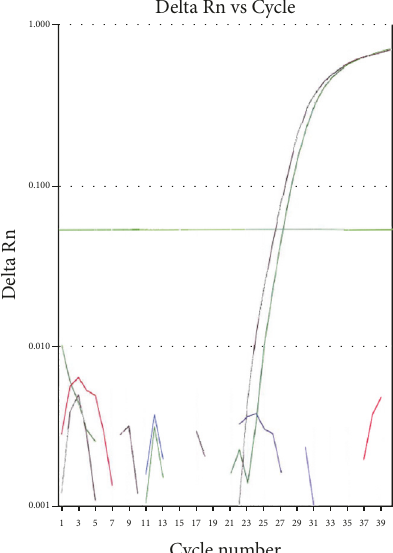
Figure 4: Real-time RT-PCR showing the MLL/MLLT10 fusion transcripts from patient #1. Delta Rn = normalized fluorescence reporter signal minus baseline; cycle number = cycle of PCR; purple is the positive control; green is the patient; red is no-template control; blue is the negative control (HL60 cell line).